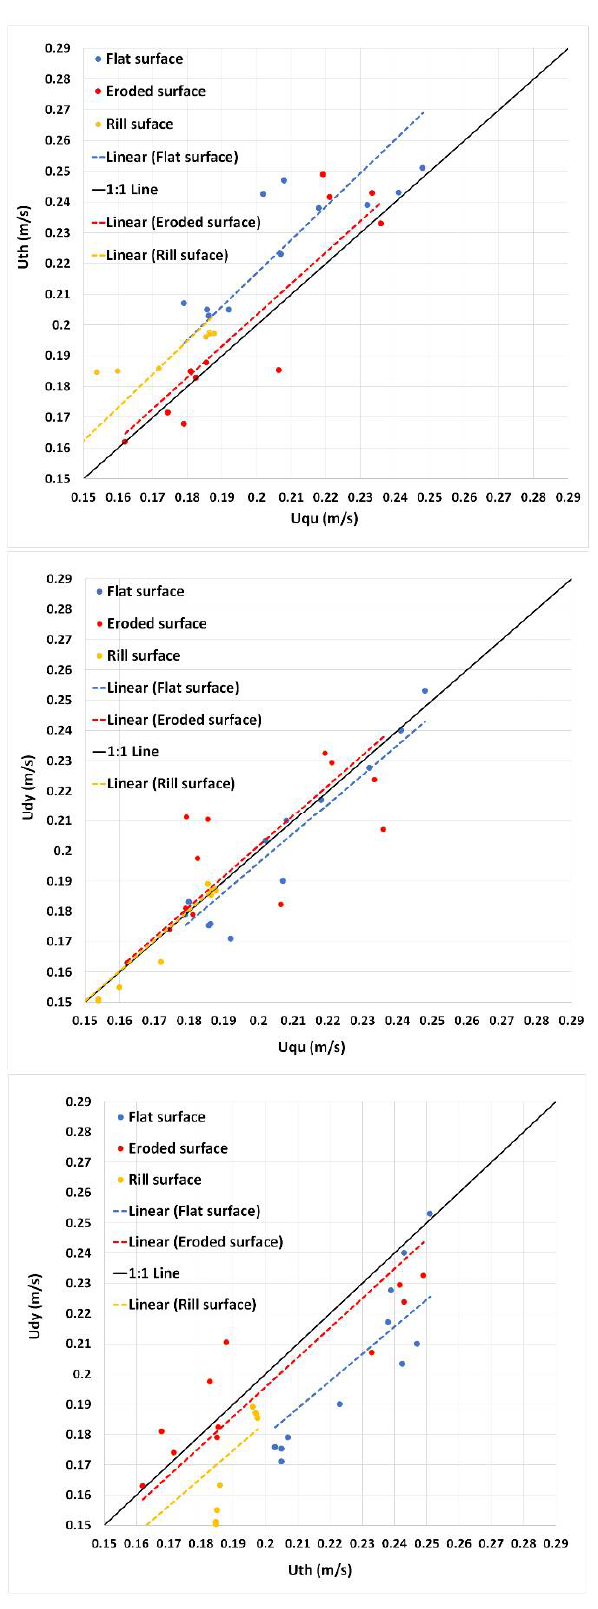
Figure 7. Comparison between velocities measured by the quinine (Uqu), dye (Udy) and thermal (Uth) tracer techniques, for the flat plane, eroded surface and artificial straight rill. Line 1:1 and linear regression lines are also plotted. Note that the axes are not at the origin (0,0).